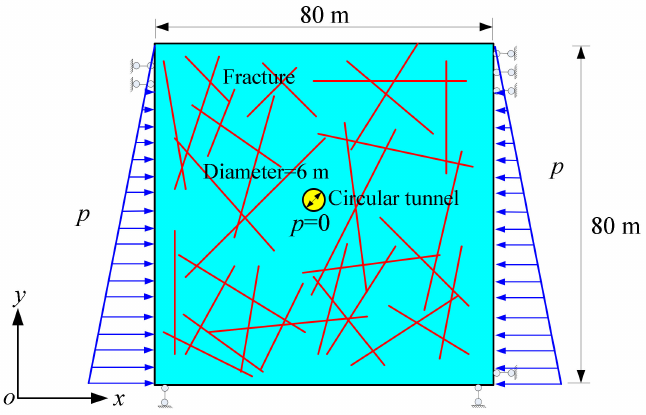
Figure 6. Geometry model of